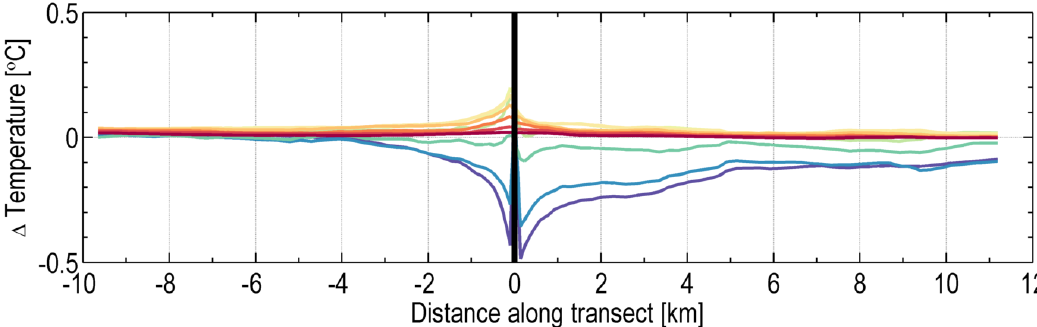
Figure 23. Difference in temperature due to HCB relative to test 1, plotted along Transect-b for all model layers. The plot shows average temperature difference for all hourly time steps over the calibration period of 25 April–11 June 2017. (The distance between −10 km and 0 km represents the region south of the bridge, while that between 0 km and 10 km represents the region north of the bridge).